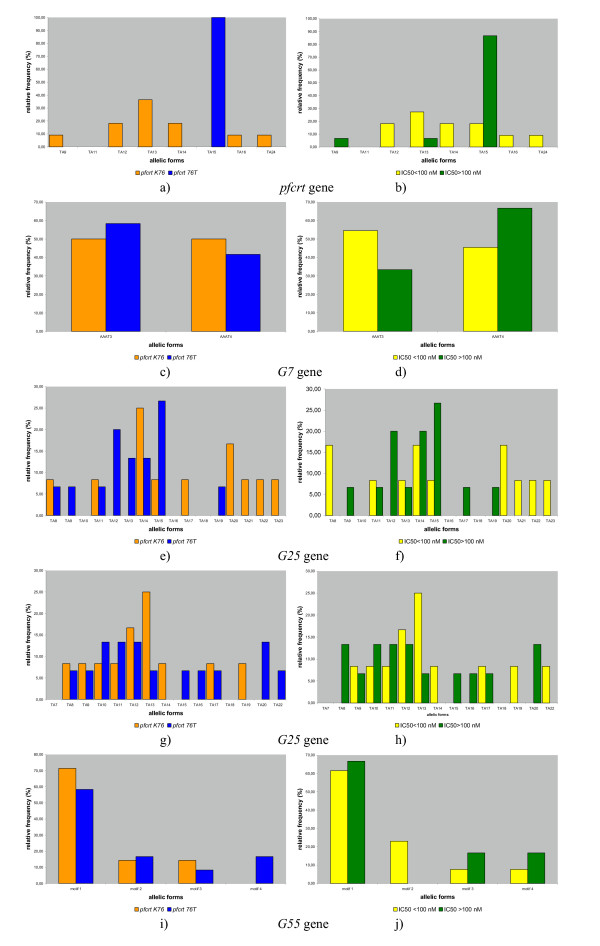
Microsatellite allelic frequencies of pfcrt and putative transporter genes in 27 P. falciparum isolates according to pfcrt 76 allele and chloroquine response phenotype. Microsatellite allelic relative frequencies are given according to pfcrt K76 (wild allele, orange bars) or pfcrt K76T (mutant allele, blue bars) (Figure a, c, e, g and i), or according to inhibitory concentration values (IC50) for chloroquine (susceptible isolates, yellow bars; resistant isolates, green bars) (Figure b, d, f, h and j). The relative frequency of the various allelic forms within each haplotype subgroup is indicated. The microsatellites have either (AAAT)n alleles or (TA)n alleles and they are classified according to the number (n) of repeats. Figure a, b: pfcrt microsatellite in intron 4; Figure c, d: G7 microsatellite; Figure e, f: G25 microsatellite in intron 3; Figure g, h: G25 microsatellite in intron 4; and Figure i, j: G55 microsatellite. Motif 1: TAATATTATAATAT(TA)9T Motif 2: TAATAT(TA)11TMotif 3: TAATAT(TA)10T Motif 4: TAATAT(TA)9T.